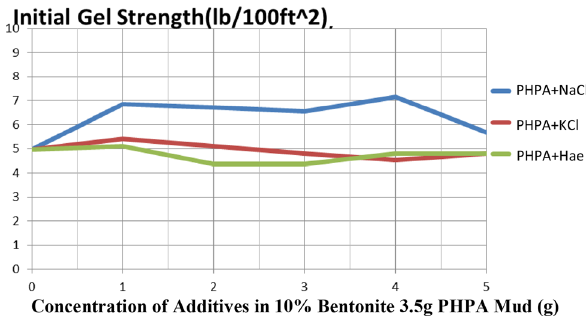
Fig. 17 Effect of NaCl, KCl and haematite on gel strength (initial) of PHPA–bentonite